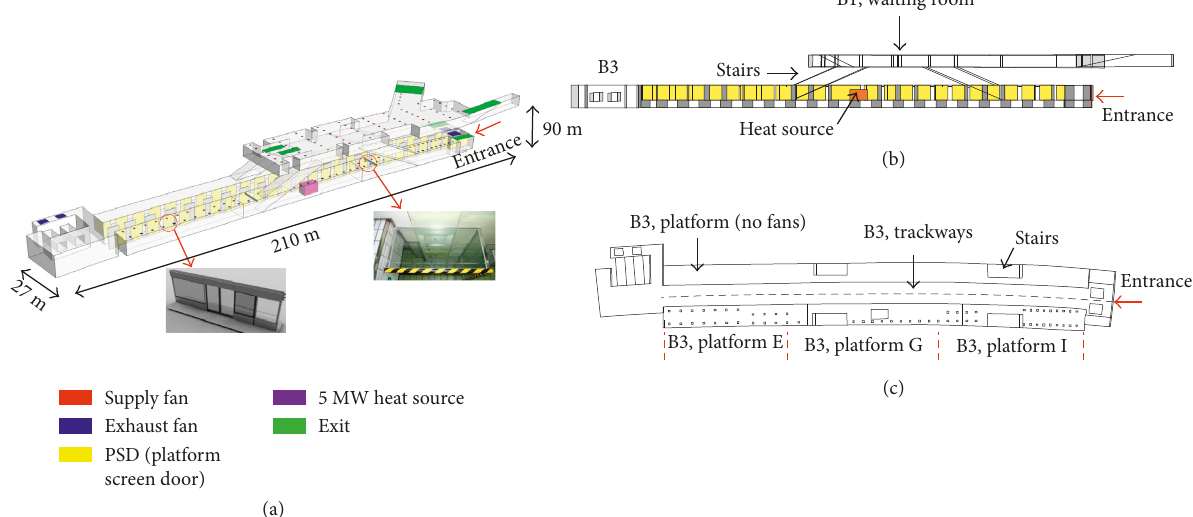
Figure 1: Underground subway station for 3D numerical simulation. (a) Underground subway station. (b) Side view. (c) Top view.